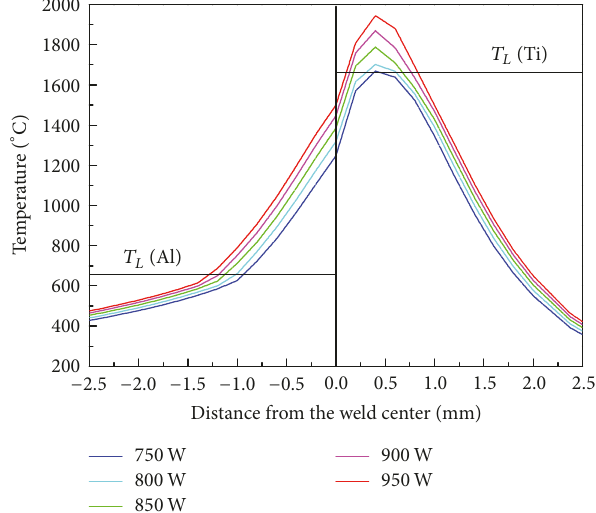
Figure 11: Dependence of computed temperatures on the distance from the weld centerline for different laser powers and the laser beam offset of 250 𝜇 m.